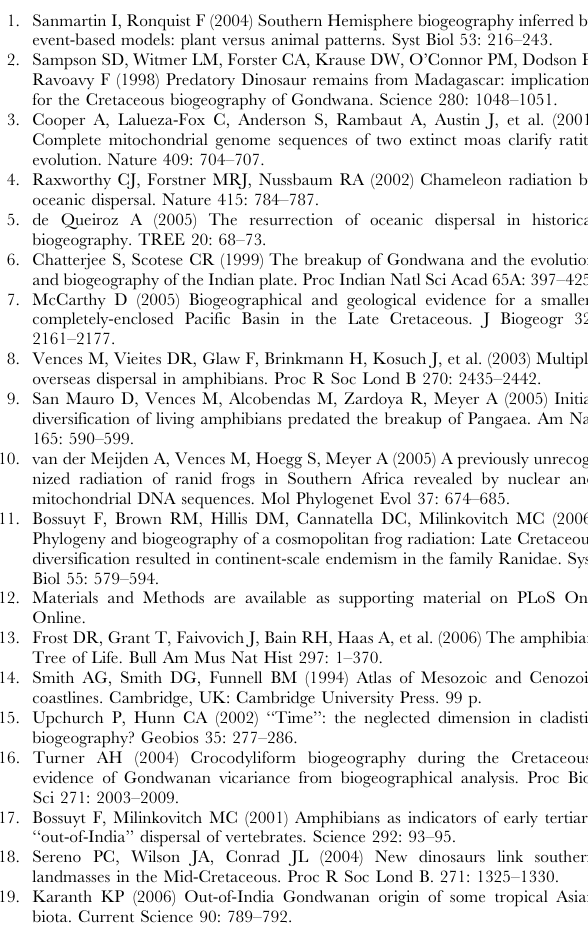
Table S8 Calibration points used in this study.